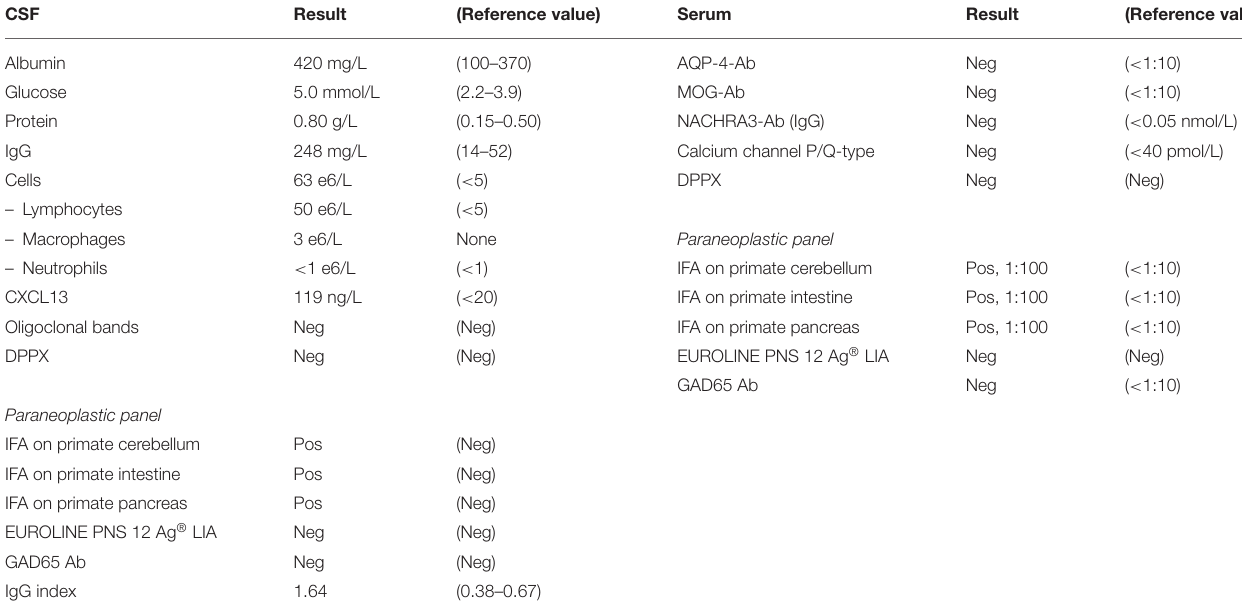
TABLE 1 | CSF and serum findings after two doses of 1g i.v. MP and one treatment with PEX.